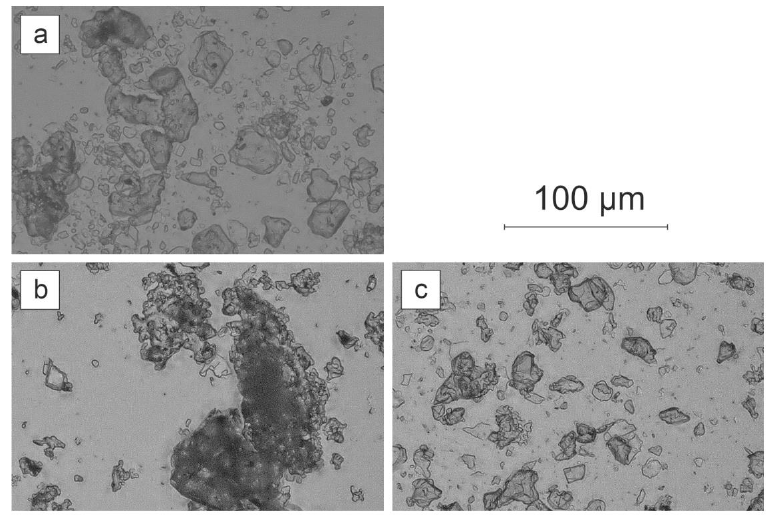
Figure 8. Digital light microscopy images of EB grains after different dispersion operations: ( a ) ref- erence powder, ( b ) horizontal bead mill (II), ( c ) three-roll mill (III) with medium M1.